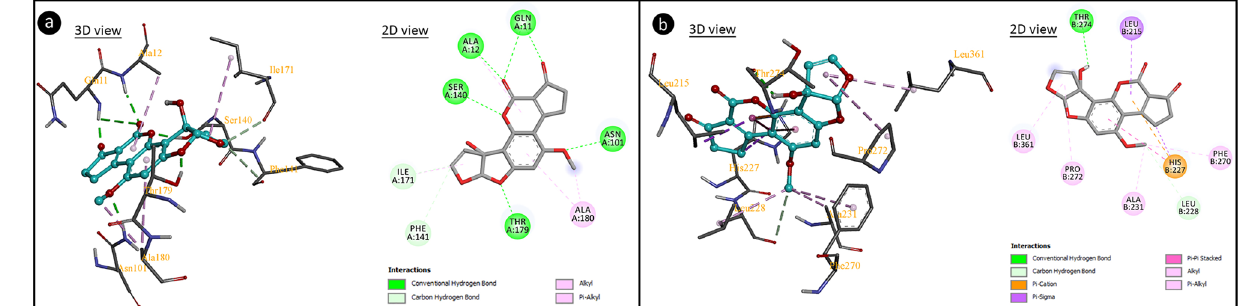
Figure 10. The molecular docking of AFM 1 with tubulin proteins ( a : α- tubulin, b : β- tubulin).